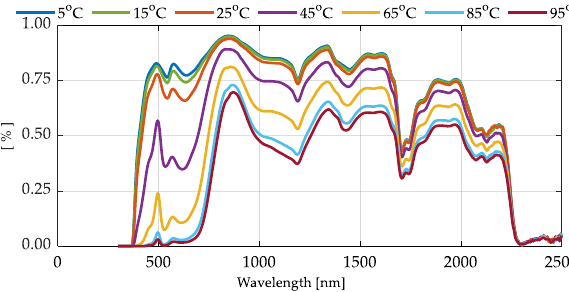
Figure 5. Transmittance of the thermochromic film for various temperatures.